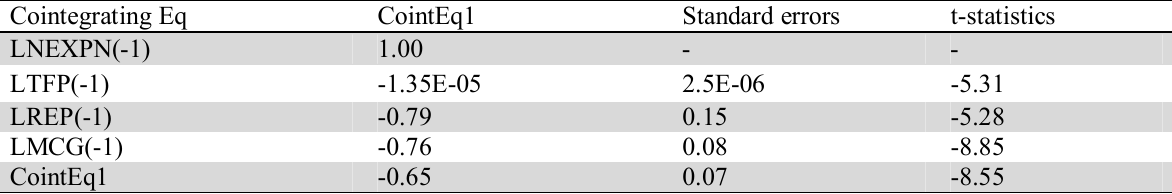
The result of vector error correction model